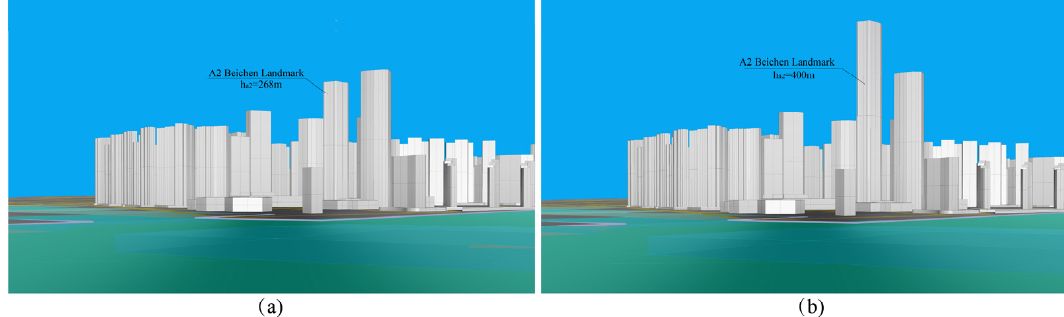
Buildings 2023 , 13 , x FOR PEER REVIEW